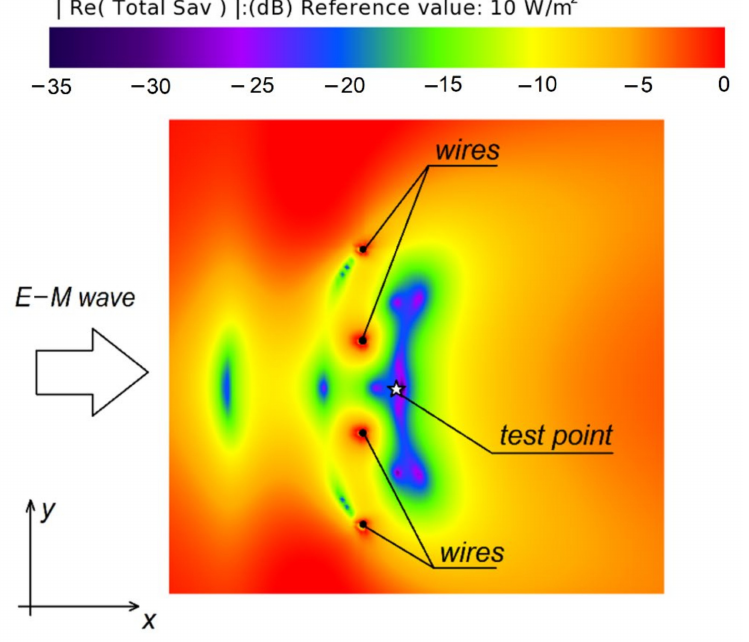
Figure 7. Power density distribution in the x − y ( z = 0) plane for the four wire array (the length of wires: 47 mm, conductivity: 500 S/m. Values given in logarithmic scale with reference value 10 W/m 2 .